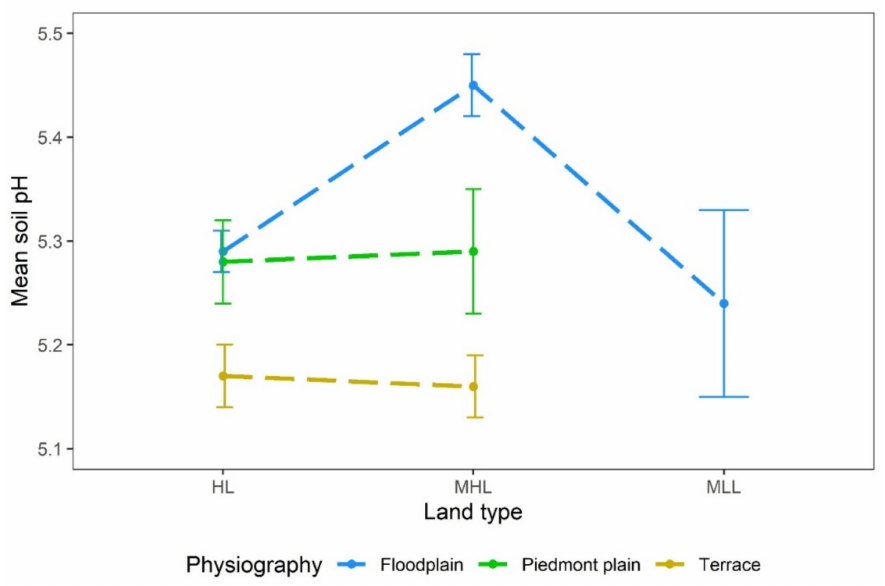
Figure 6. The main effect of land type (highland = HL, medium highland = MHL, medium lowland = MLL) on soil pH (0–15 cm) in the Floodplain, Piedmont plain and Terrace physiography.